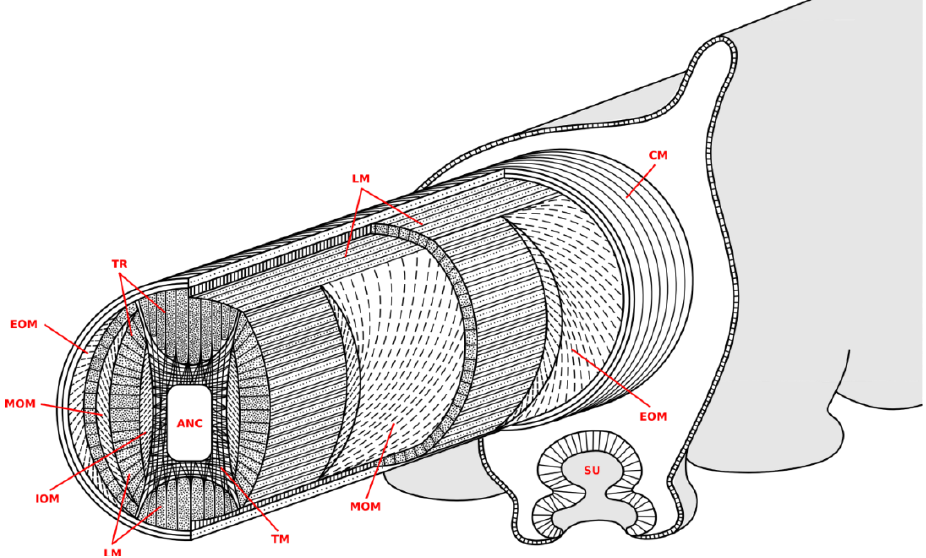
Figure 1. The muscle arrangement within the octopus arm: the longitudinal muscles (LM) run along the arm, while the transverse muscles (TM) lay on the cross section and are connected to the external connective tissue by means of the trabeculae (TR); oblique muscles are arranged helicoidally and they are divided into external (EOM), medial (MOM) and internal (IOM) muscles; in the inner and outer sides of the arm, the axial nerve cord (ANC) and a thin layer of circumferential muscles (CM) are lodged, respectively. A sucker (SU) is also depicted in the bottom